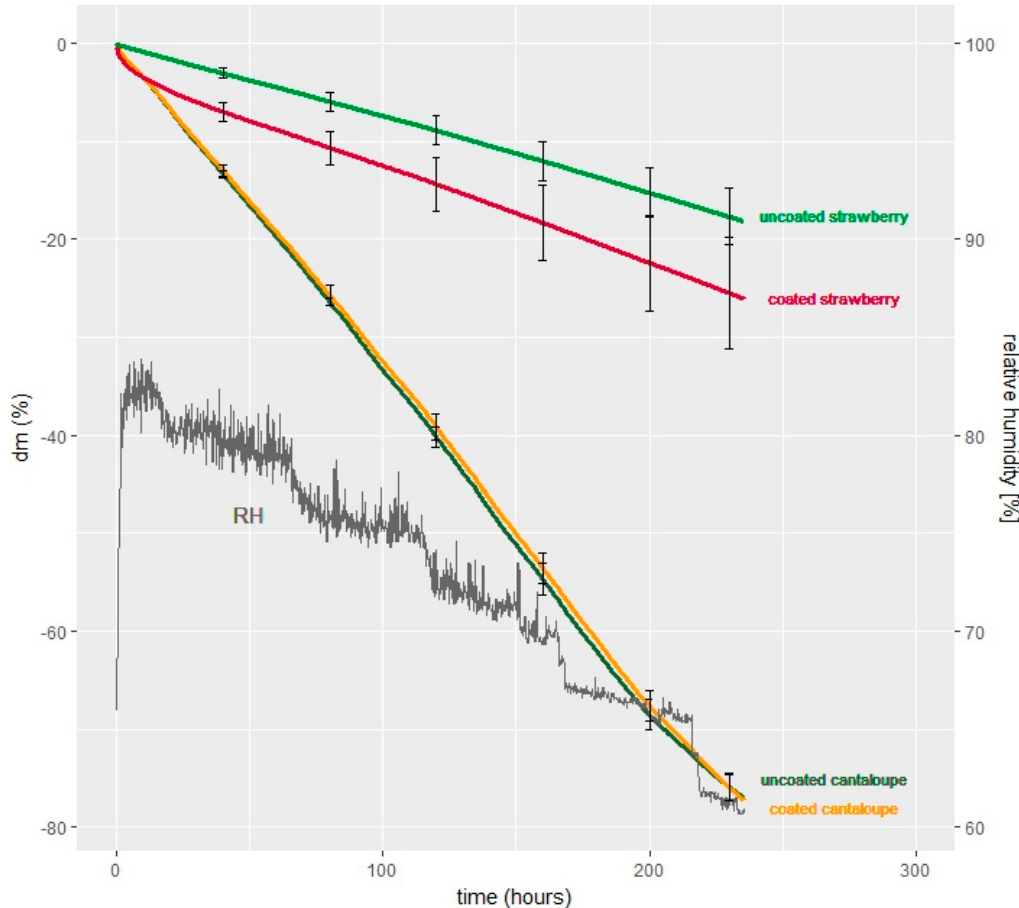
Figure 4. Mass loss (dm, %) of coated and uncoated strawberries and fresh-cut cantaloupes at 10 °C during gradual RH decrease (80% → 60% RH) ( n = 4). (Coating solution: 1.25% alginate + 2 glycerol + 0.2% sunflower oil + 1% span 80 + 0.2% tween 80 and 2% calcium lactate (crosslinking agent)).